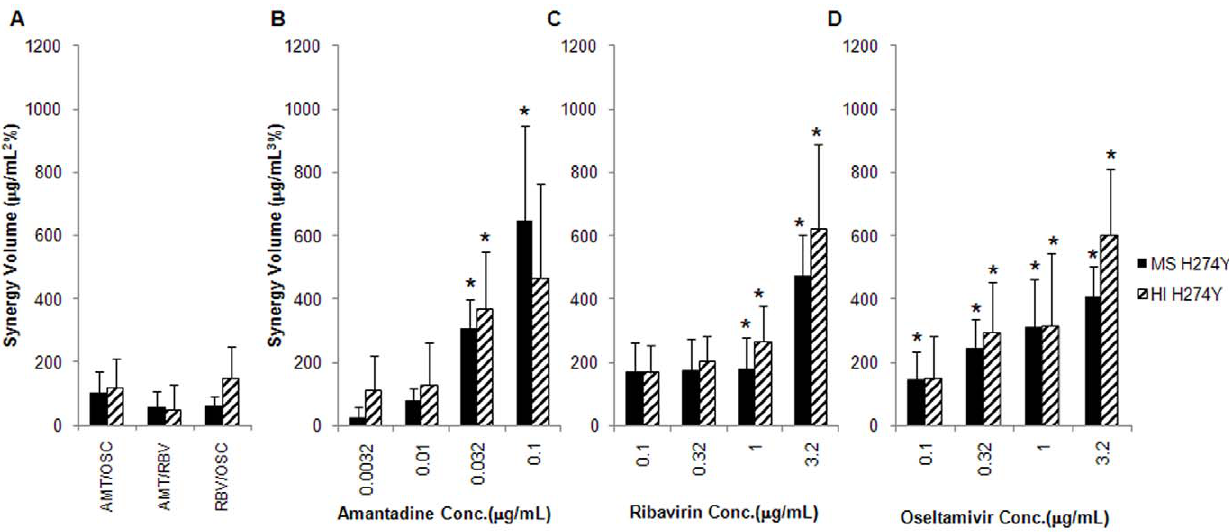
Figure 3. Synergy of double and triple combinations of amantadine, ribavirin, and oseltamivir carboxylate against oseltamivir- resistant H1N1. Oseltamivir-resistant H1N1 viruses were incubated with MDCK cells in the presence of drugs, and CPE was determined by Neutral Red assay. Synergy volumes are plotted for each double combination, and for the triple combination as a function of increasing concentration of each drug as the third drug. Black bars, A/Mississippi/3/01 H274Y (MS H274Y); hatched bars, A/Hawaii/21/07 H274Y (HI H274Y). (A) Double combinations of amantadine/oseltamivir carboxylate (AMT/OSC), amantadine/ribavirin (AMT/RBV), and ribavirin/oseltamivir carboxylate (RBV/OSC). Triple combination of amantadine, ribavirin, and oseltamivir carboxylate as a function of (B) amantadine concentration, (C) ribavirin concentration, and (D) oseltamivir carboxylate concentration. Data are presented as the mean between 18 replicates from 6 experiments with 95% confidence intervals. The concentrations of each drug used in double and triple combinations are provided in Table S1. * P , 0.05 versus double combination without drug.